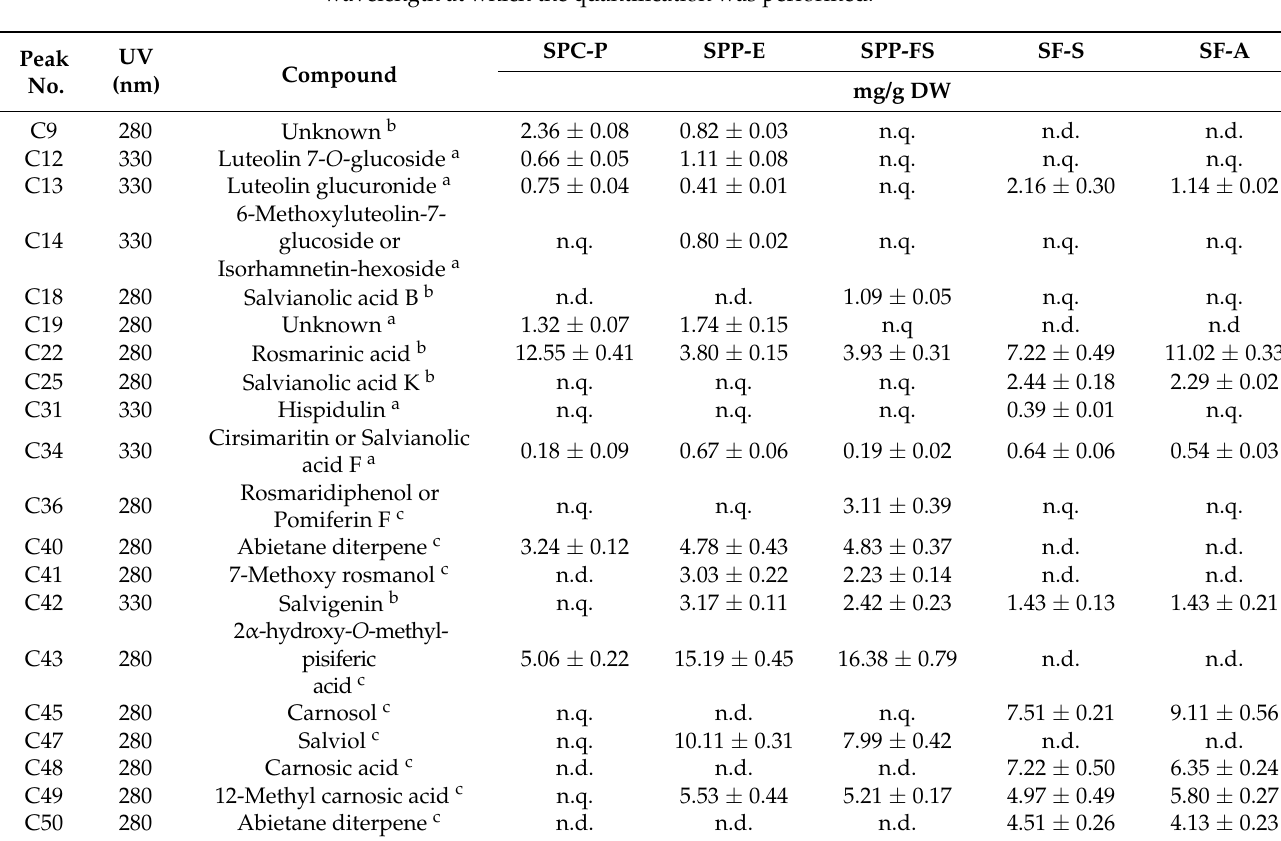
Table 3. Concentration of the major polar metabolites in mg g − 1 dry extract weight in each population. The first column shows the peak numbers as presented in Table 2 and the second column, the wavelength at which the quantification was